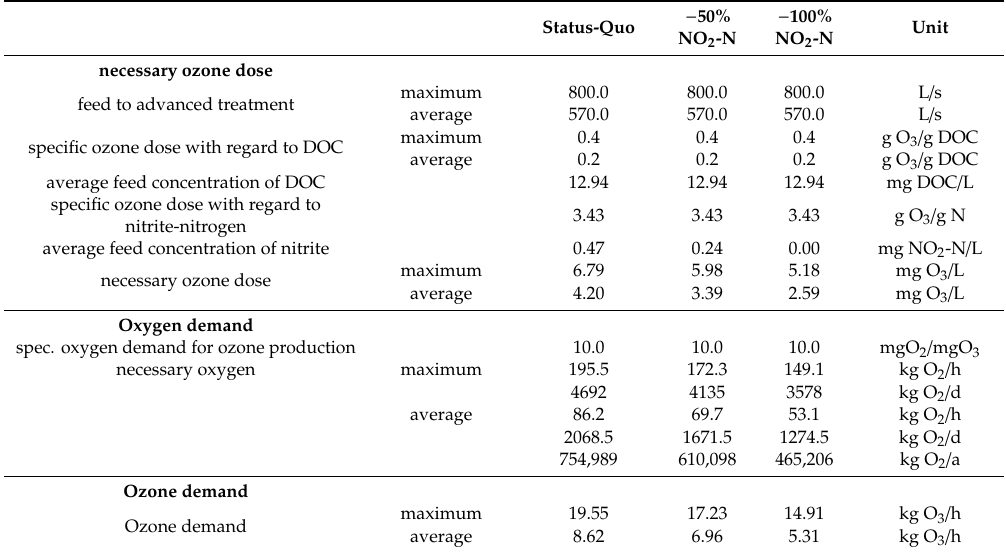
Table A1. Impact of the reduced nitrite-concentration on oxygen and ozone demand in the advanced treatment step for OMP